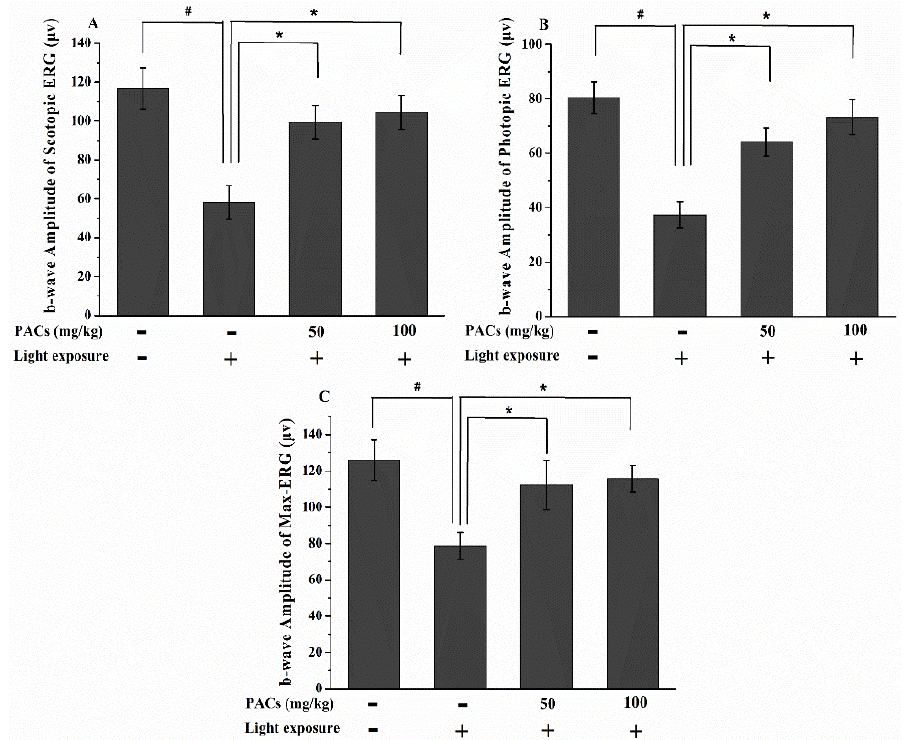
Figure 1. b -Wave amplitudes of ( A ) scotopic electroretinogram (ERG), ( B ) photopic ERG and ( C ) max-ERG from retinas in rabbits in the control group (CG), model group (MG), low dosage proanthocyanidins (LPACs) and high dosage PACs (HPACs) groups 7 days after light exposure. Data are expressed as the mean ± standard deviation ( n = 8). (#, ∗ ) p < 0.05 (one‑way ANOVA followed by Tukey’s test). CG: no light exposure and vehicle administration; MG: 18,000 lx light exposure and vehicle administration; LPACs: 18,000 lx light exposure and administration of low-dosage sea buckthorn seed PACs (50 mg/kg); HPACs: 18,000 lx light exposure and administration of high-dosage sea buckthorn seed PACs (100